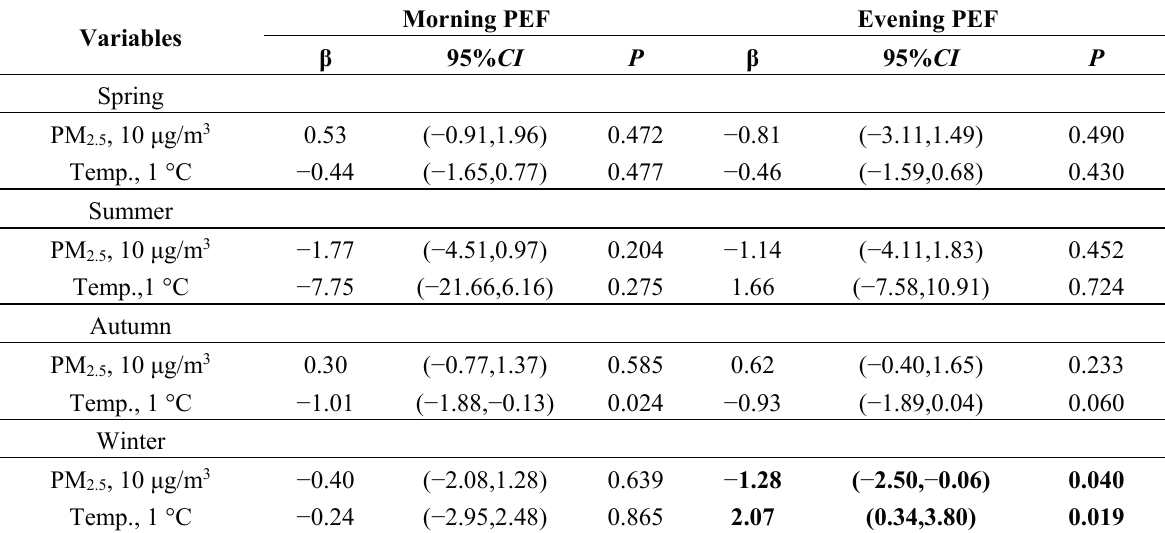
Table 5. Seasonally stratified analysis of effects of outdoor PM 2.5 and temperature on PEF of the current